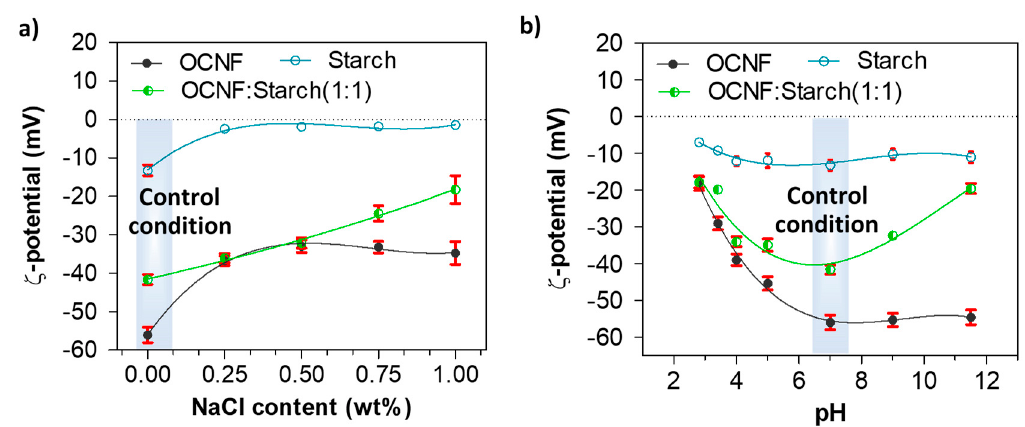
Figure 7. ζ -potential values (with standard deviation, n = 5) of OCNF, starch, and OCNF:starch (1:1) hydrogels (0.1 wt% in DI water): ( a ) with increasing NaCl content up to 1 wt% and ( b ) at various pH conditions.